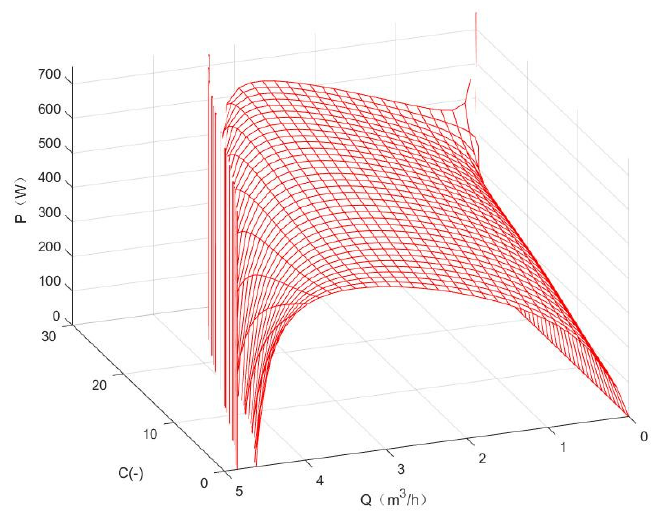
Figure 7. Empirical function diagram of ice concentration and pump power.